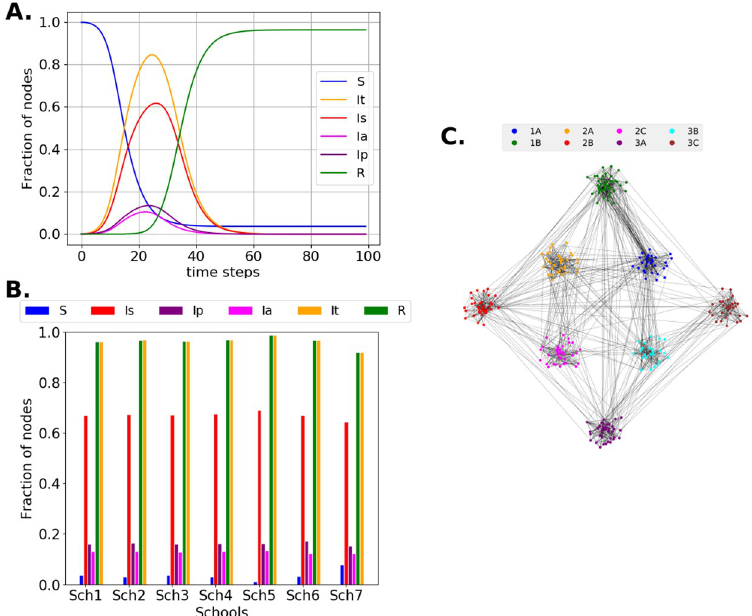
Fig 3. A . Stage 1 for Sch4. Blue S, red Is, purple Ip, magenta Ia, orange fraction of nodes infected with any type of symptom, and green R agents. B . All school networks in stage 1: the accumulated percentages of agents at each state are shown for every school. The results shown in A and B have 30% of agents without symptoms, from which 45% are asymptomatic. C. Sch2 network obtained. The nodes are classified by classrooms.